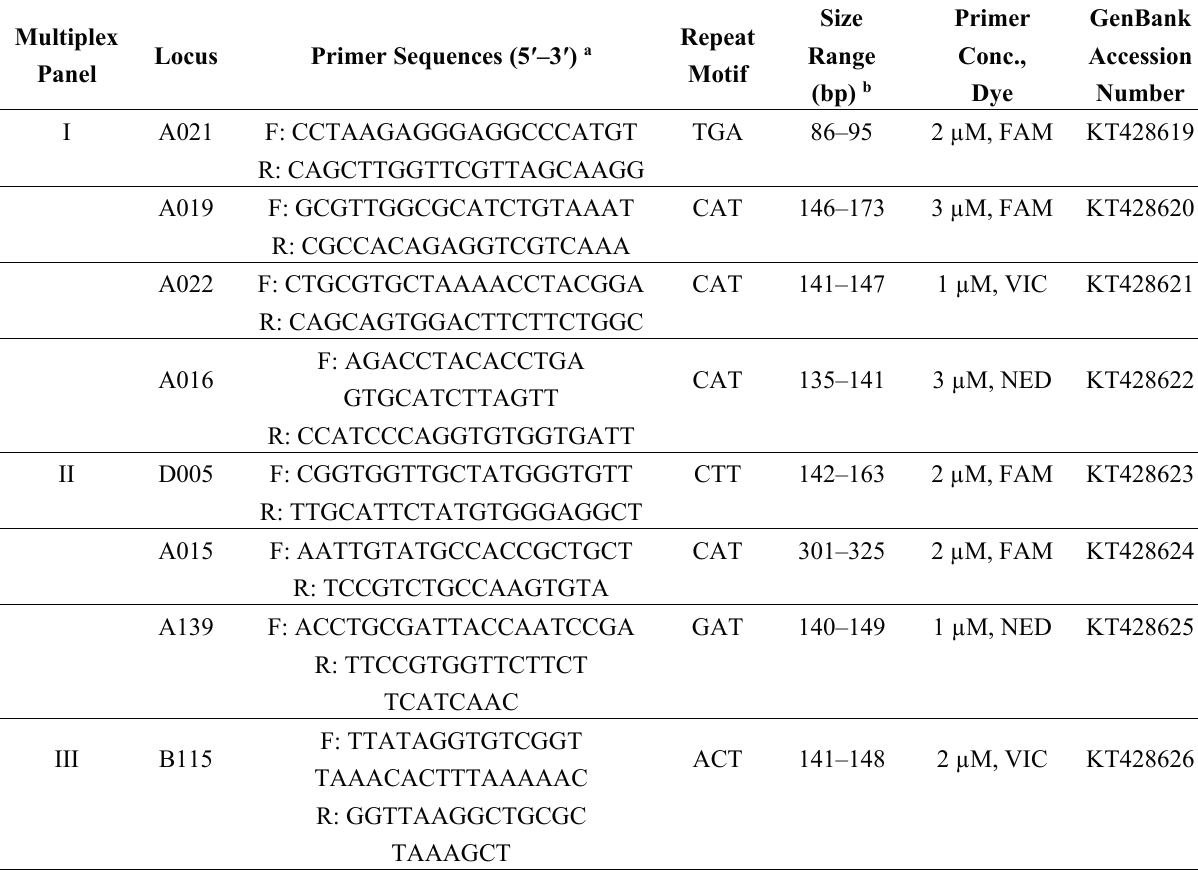
Figure 1. Chromatograms from capillary electrophoresis (ABI 3130xl) showing multiplex PCR reactions I–VI (see also Table 1) for the 21 microsatellites developed for E . autumnata . The peak height (Relative fluorescence units (RFU)) is indicated on the Y -axis, and fragment length (base-pairs) is indicated on the X -axis. The names of the microsatellites markers are indicated below the peaks. Table 1. Twenty-one microsatellite loci arranged into six multiplex PCR panels for E.